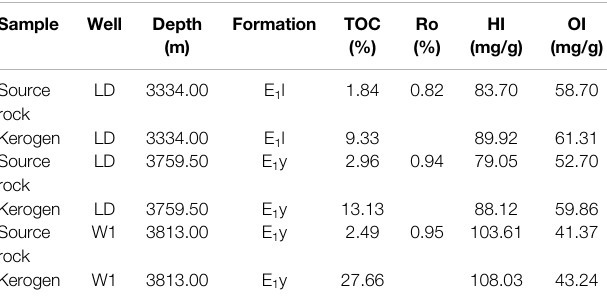
TABLE 1 | Basic information of the selected